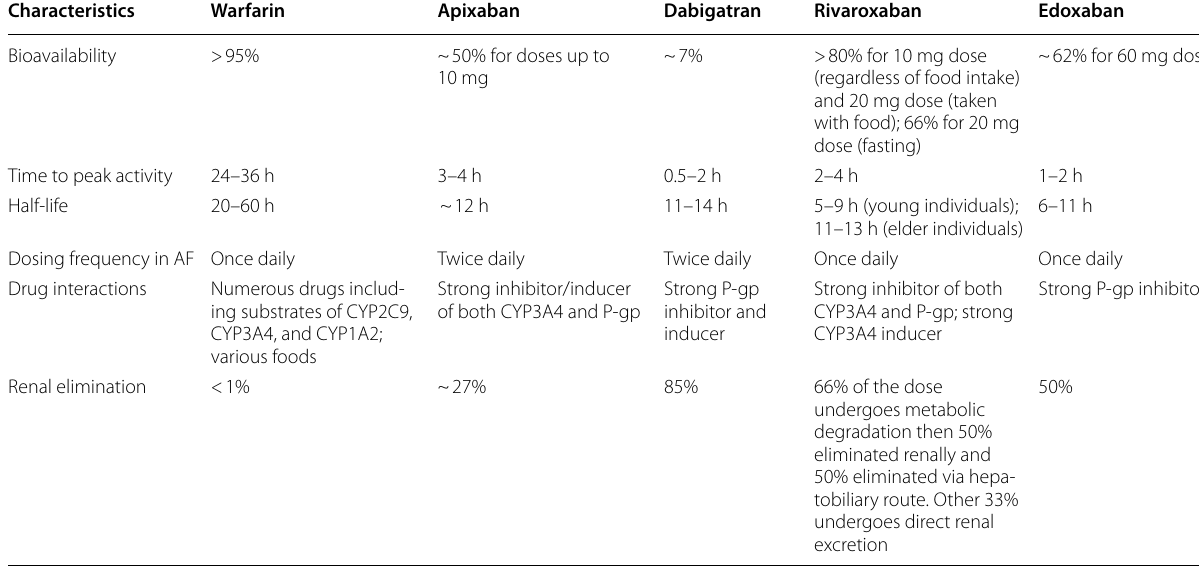
AF, atrial fibrillation; CYP, cytochrome P450; P-gp, P-glycoprotein